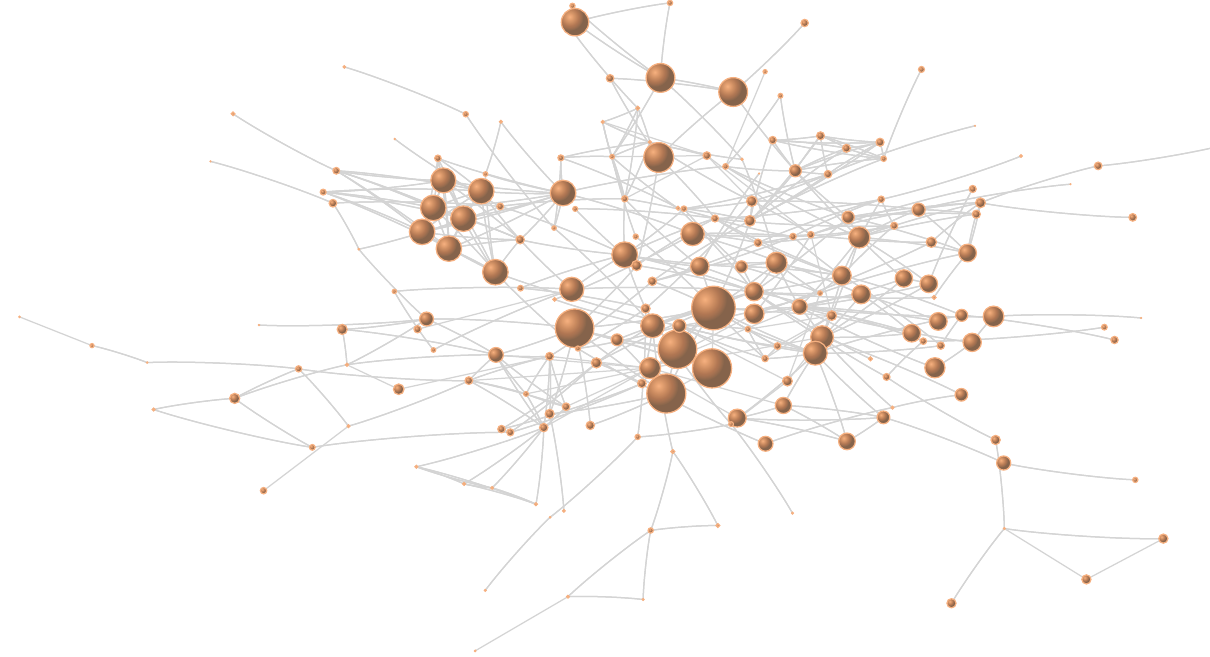
Figure 1: Main component of board interlocking between Brazilian companies . Main component (𝑛 = 187) . Data for the 2010 year. The size of vertices corresponds to the social capital value of companies: the sum of relational resources. Each vertex is one company, and edges indicate board interlocking. Visualization algorithm: Kamada-Kawai, Note . Developed by the authors based on the data